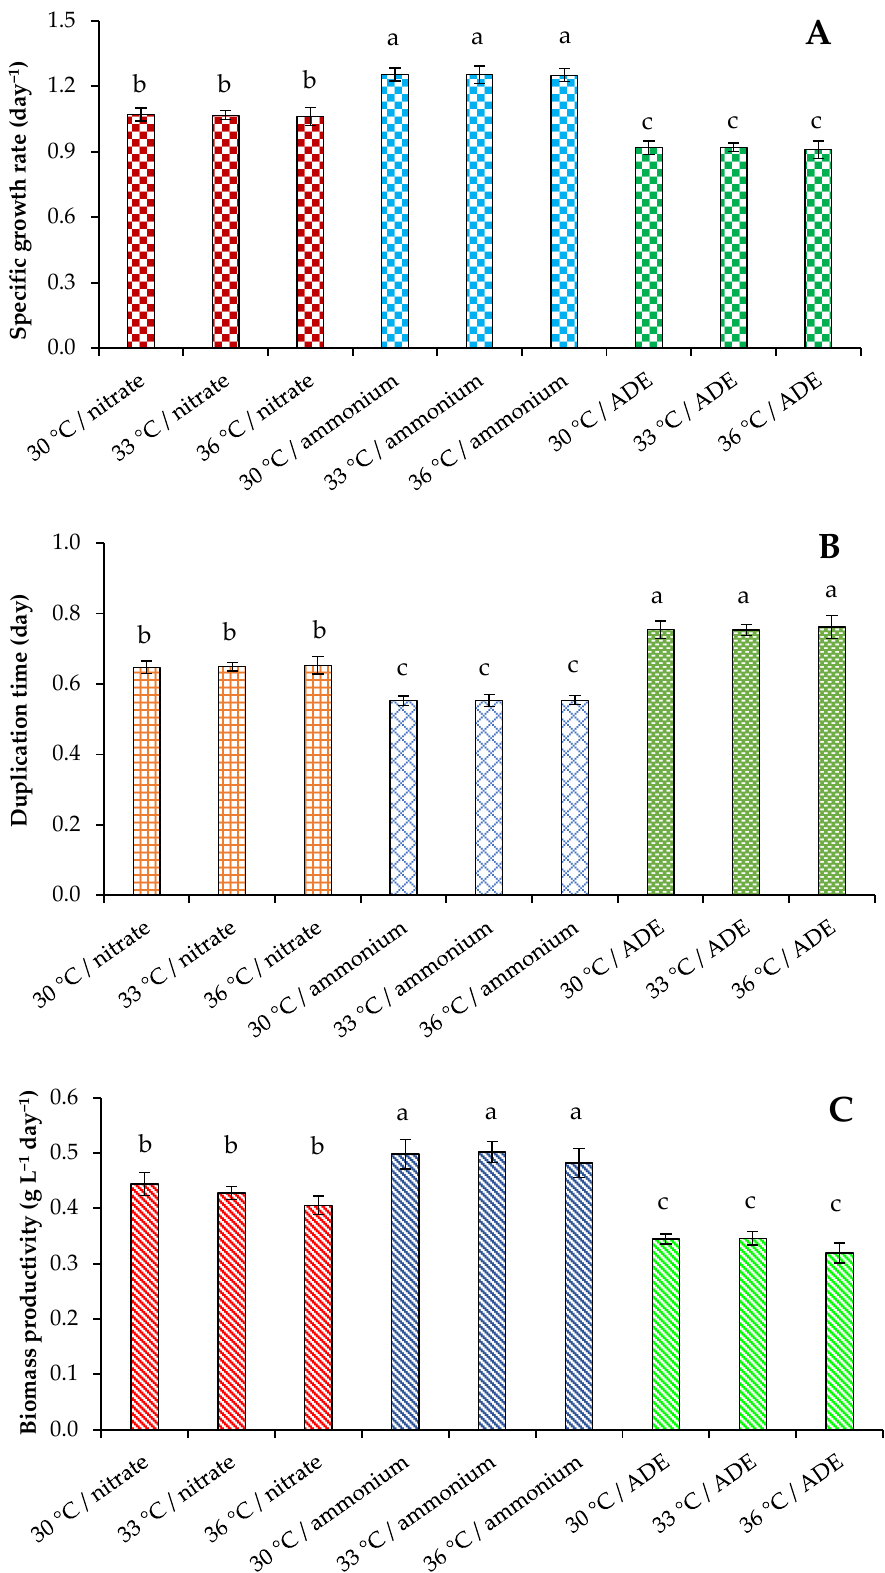
Figure 2. Specific growth rate ( A ), duplication time ( B ), and biomass productivity ( C ) of cultures of C. sorokiniana AM-02 grown under different strategies. Means that do not share a letter are significantly different.